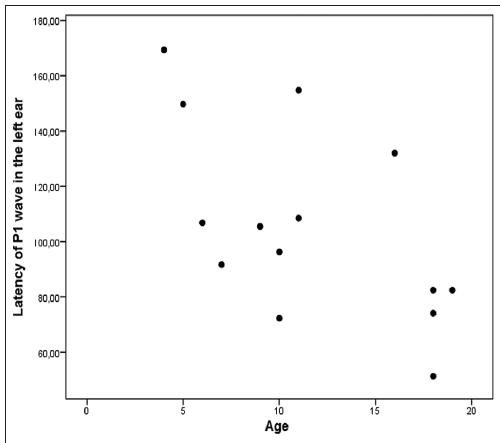
FIGURE 2. Scatter plot considering age versus latency of P1 wave in the left